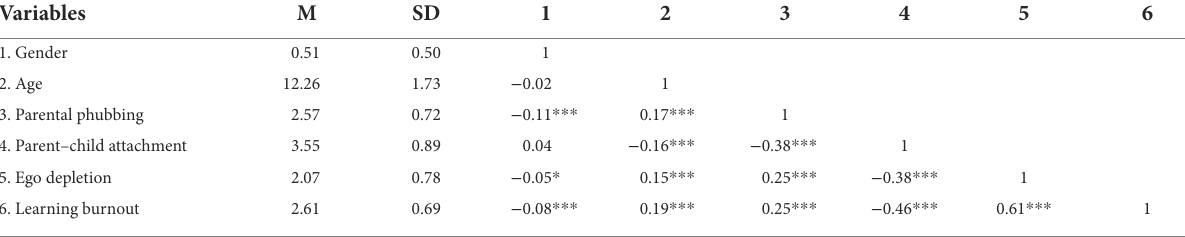
TABLE 1 Mean, standard deviation, and correlation matrix of each